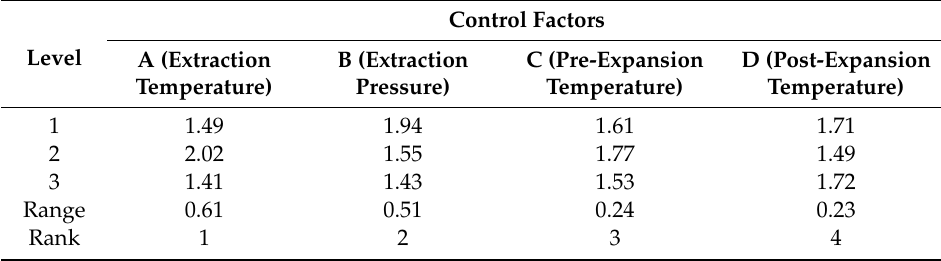
Table 4. Range and contribution rank of each factor for average particle size (unit: µ m).